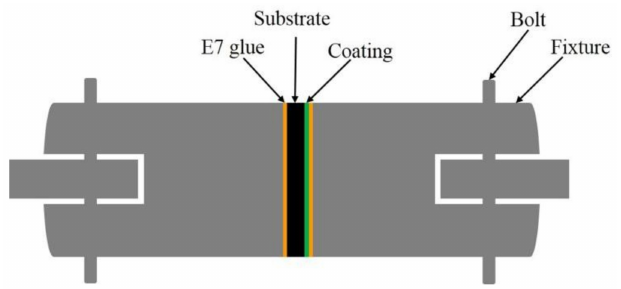
Figure 1. Sketch map of the adhesive strength tensile test.